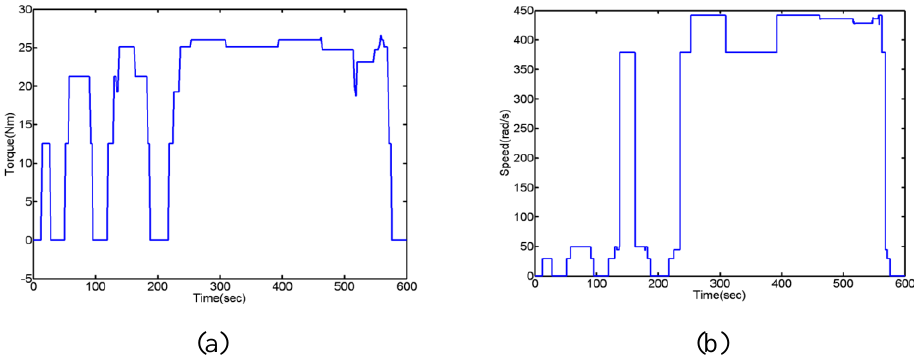
Figure 8. Output ( a ) torque, ( b ) rotational speed of power integration, and distribution mechanism .